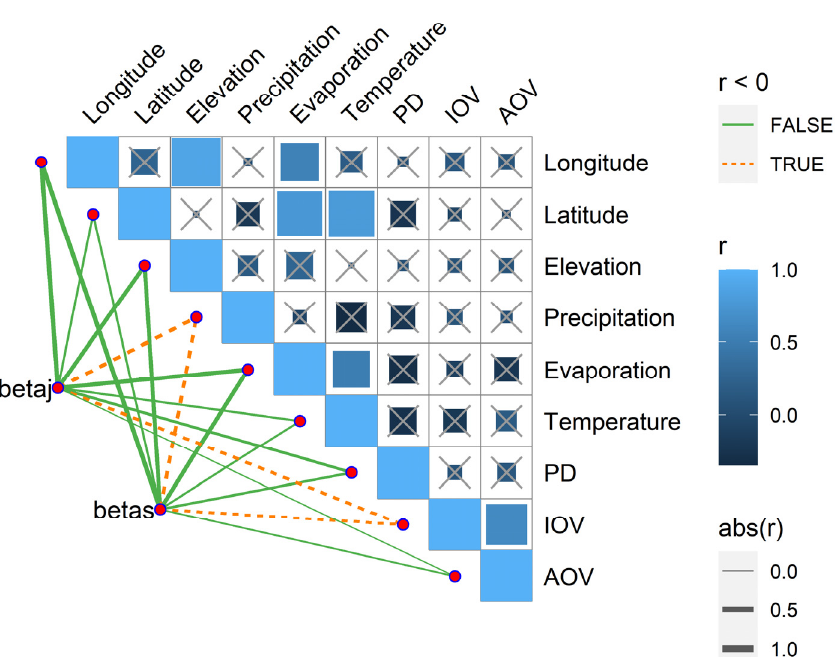
Figure 6. Relationship between natural and human environment variables and beta diversity of wetland plants. The color gradient represents the correlation coefficient. The thickness of the line indicates the correlation. The thicker the line, the stronger the correlation; the thinner the line, the weaker the correlation. PD, population density. IOV, industrial output value. AOV, agricultural output value.